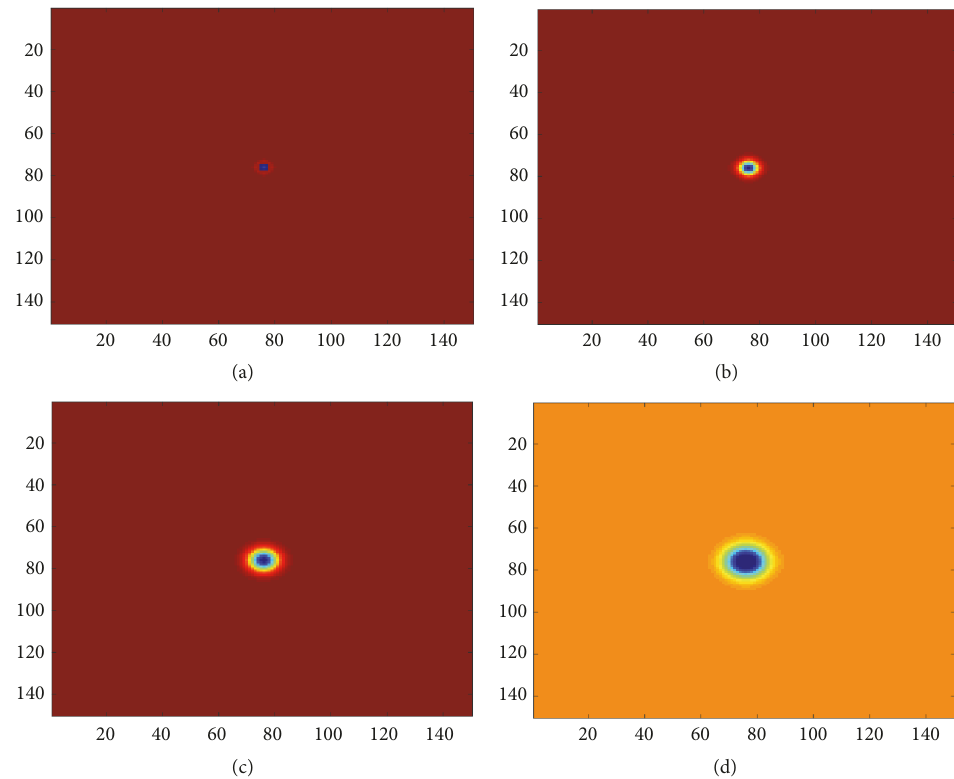
Figure 13: The snapshots of spatial distribution of membrane potential with color scale for neurons in the square array network for 𝑘 = 1.5 and 𝐷 = 1 at (a) 𝑡 = 2 time units, (b) 𝑡 = 75 time units, (c) 𝑡 = 170 time units, and (d) 𝑡 = 300 time units.